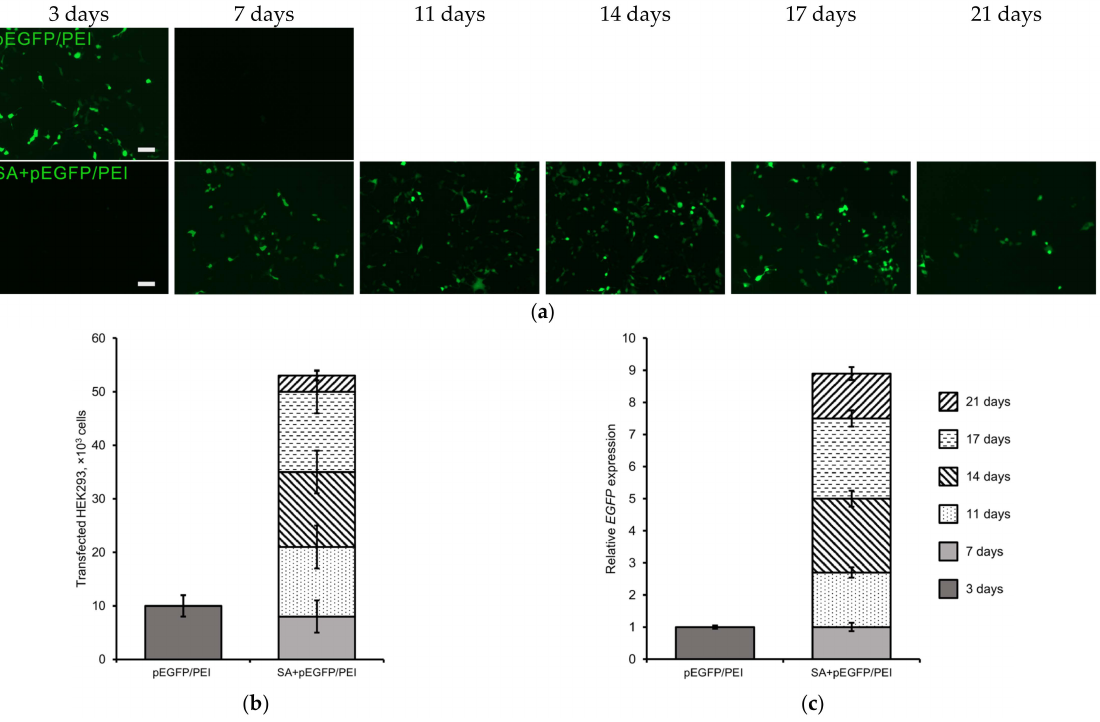
Figure 2. Transfection kinetics in vitro. ( a ) Transfected HEK293 after incubation with GASs im- pregnated with pEGFP/PEI. Fluorescent microscopy. Scale bar 100 µ m; ( b ) The number of trans- fected HEK293 cells during their incubation with gene-activated alginate scaffolds. Flow cytometry; ( c ) Relative EGFP expression level during incubation of MSCs with GASs impregnated with pEGFP/PEI. Real-time